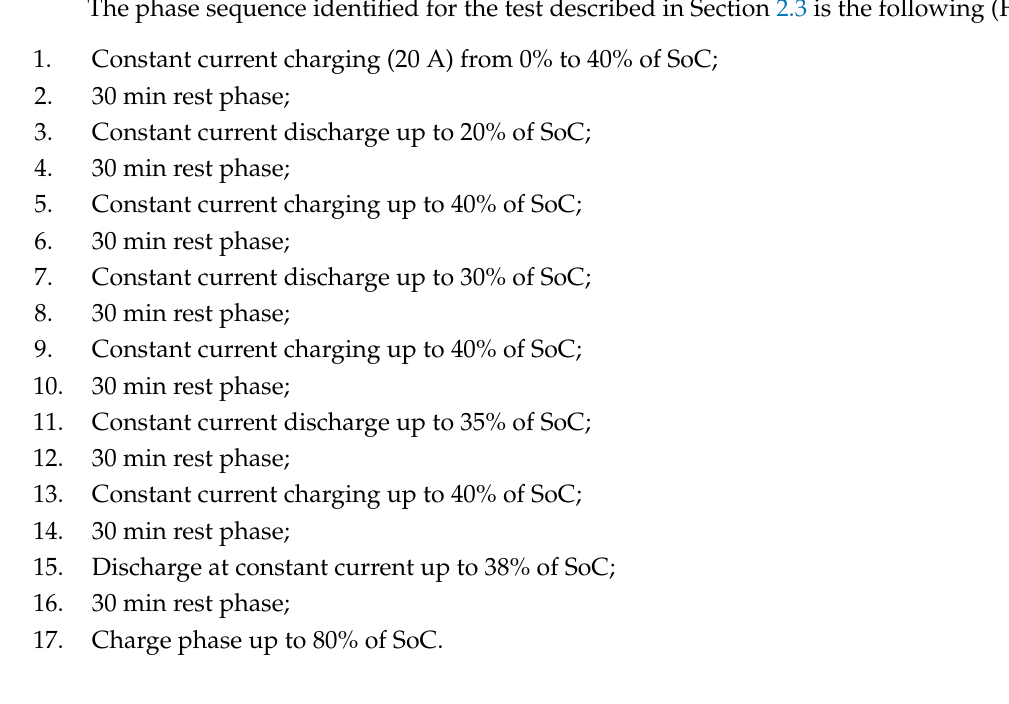
ff erence between measured and simulated voltage. Figure 14. Difference between measured and simulated voltage. Figure 14. Di